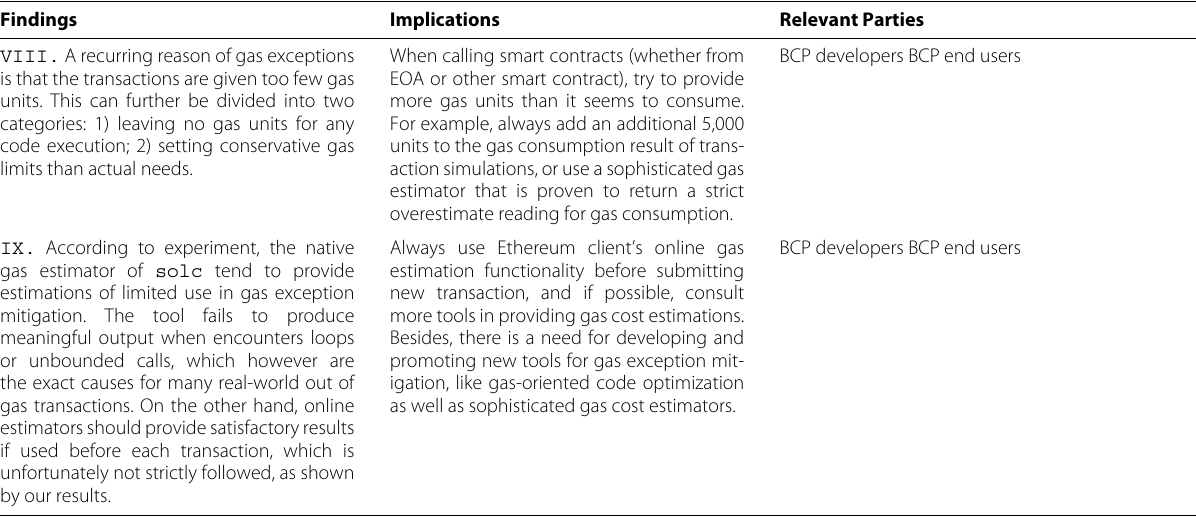
Table 9 Summary of important findings and implications ( Continued ) Findings Implications Relevant